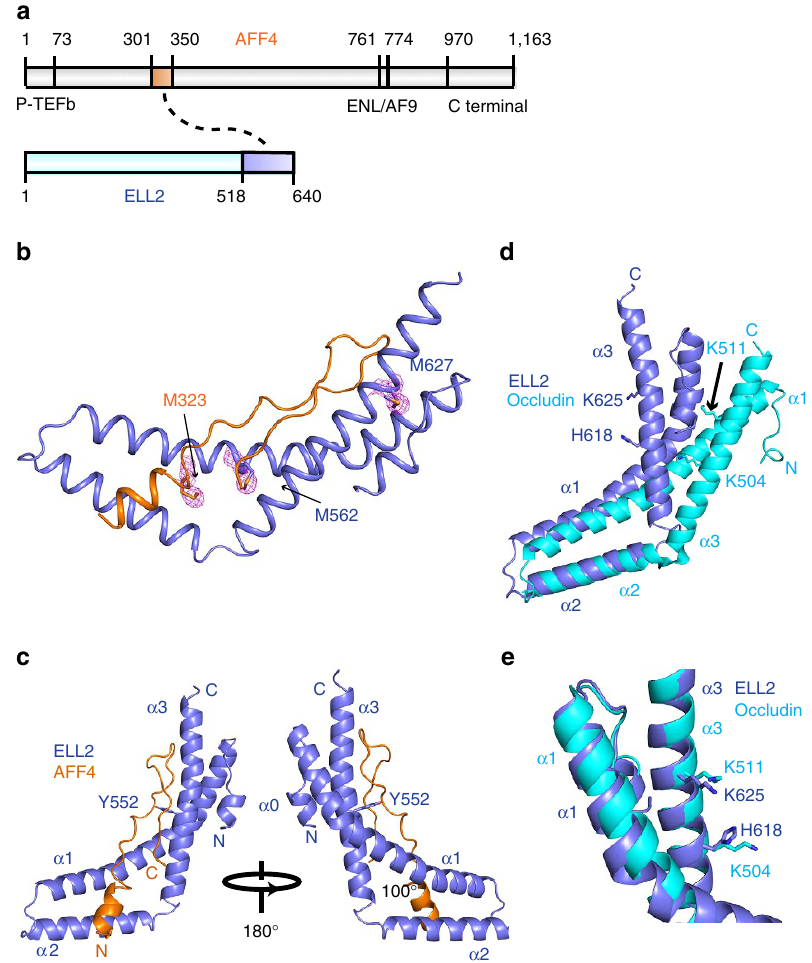
Figure 1 | Crystal structure of the AFF4 ELLBow in complex with the occludin homology domain of ELL2. ( a ) Schematic of the interactions of the AFF4 intrinsically disordered protein (IDP) scaffold with its partners in the SEC. The highlighted boxes within AFF4 and ELL2 represent the co-crystallized elements described below. Other regions of AFF4 are annotated for binding to P-TEFb, AF9/ENL and the novel C-terminal ELL1/2-binding site described below. ( b ) Se anomalous difference peaks and overall structure of the complex. The Se substructure map is displayed at a contour level of 2 s (magenta). ( c ) Two views of the overall structure of the complex, with AFF4 in orange and ELL2 in light blue. ( d , e ) Comparison of ELL2 and occludin C-terminal domain showing that the folds are similar, but ELL2 is more sharply bent. Helix a 3 from both ELL2 and occludin are aligned, the structurally and functionally conserved residues are shown in stick. ELL2 is shown in light blue while Occludin is shown in cyan. All structural figures in this paper are made with